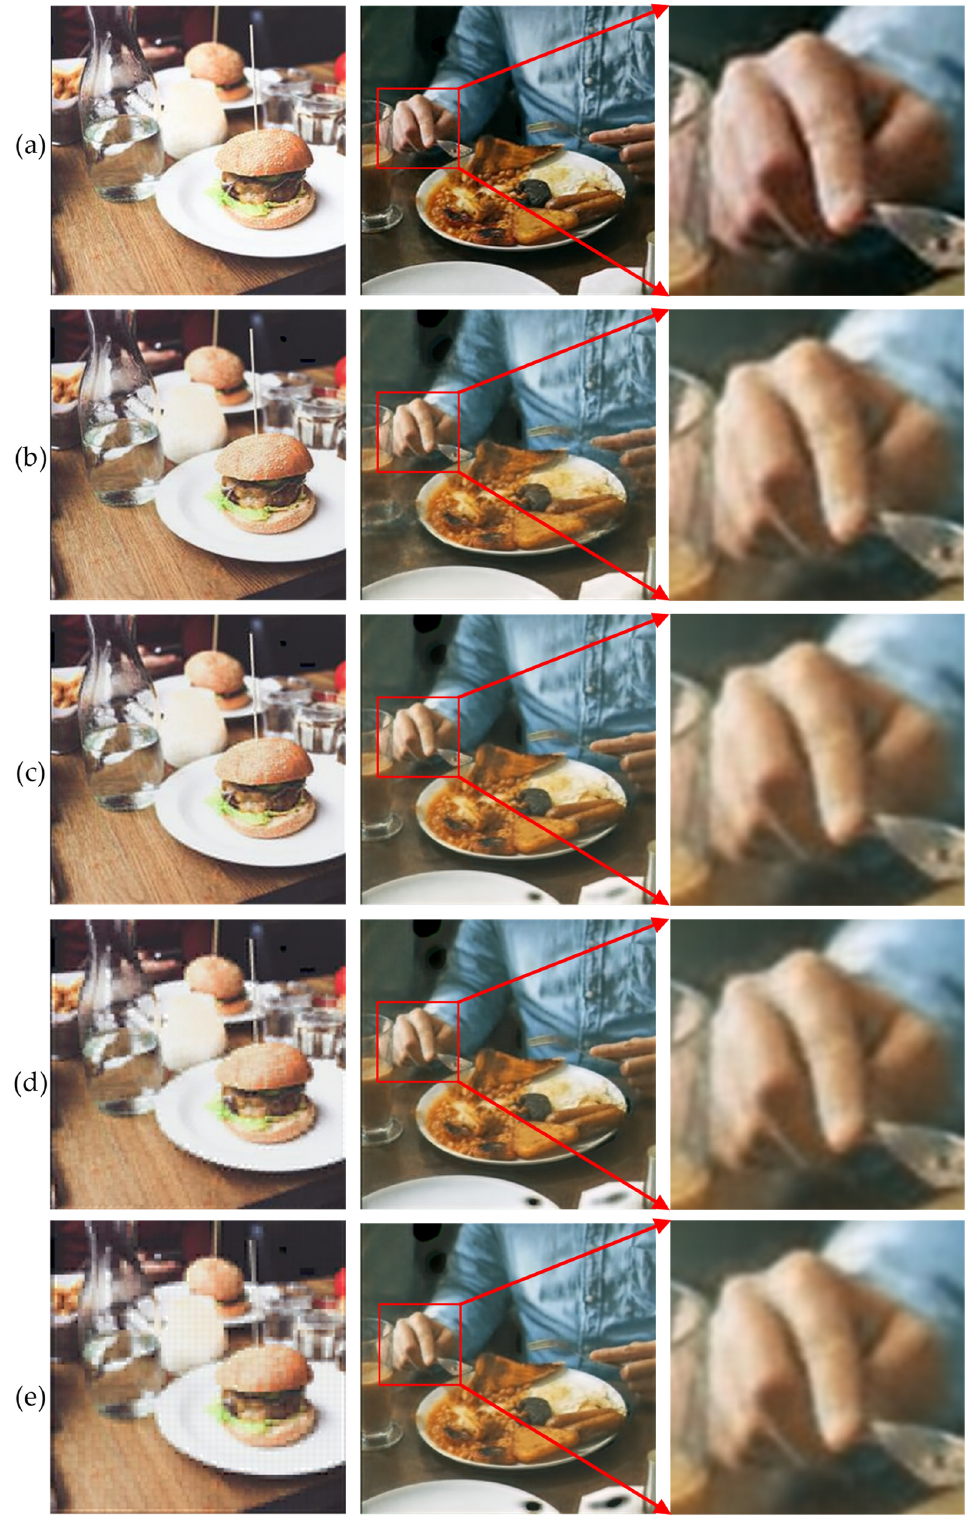
Figure 13. Comparison of secret images reconstructed from container images with different compression ratios: ( a ) 1, ( b ) 1.53, ( c ) 2.98, ( d ) 5.88 and ( e ) 11.77. From left to right correspond to compressed containers, reconstructed secret images, and magnified hand areas in the reconstructed secret images, respectively.